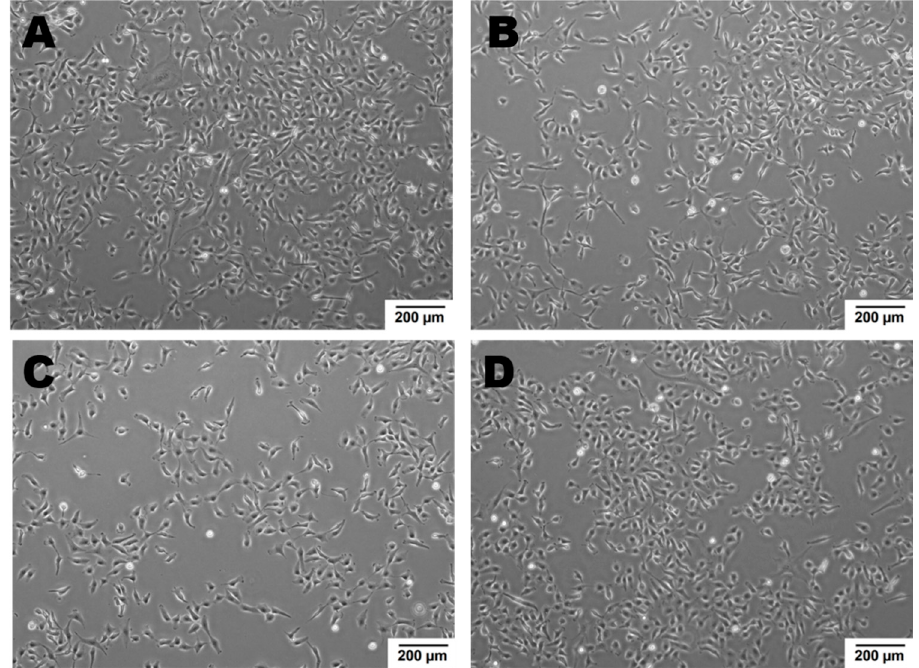
Figure 4. ECs’ growth modulated by hypoxic micro-environmental conditions. Cell density after 48 h in normoxia or hypoxia: Cells were seeded at 0 h in the same number. Growth of healthy ECs is a little slower upon hypoxia vs. normoxia, oppositely to cancer derived ECs, whose growth is higher in hypoxic conditions as compared to normoxia. ( A )—healthy ECs, normoxia; ( B )—healthy ECs, hypoxia; ( C )—cancer-derived ECs, normoxia; ( D )—cancer-derived ECs, hypoxia; magnification 4 ×.